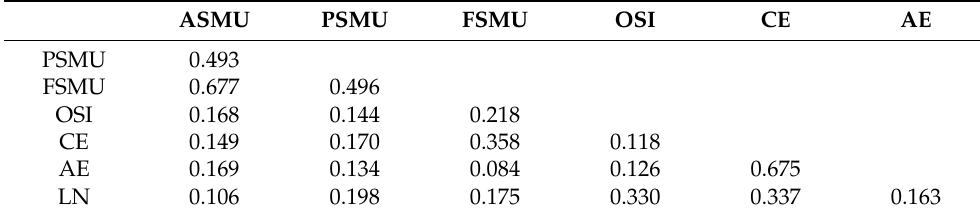
Table 2. HTMT ratio of the